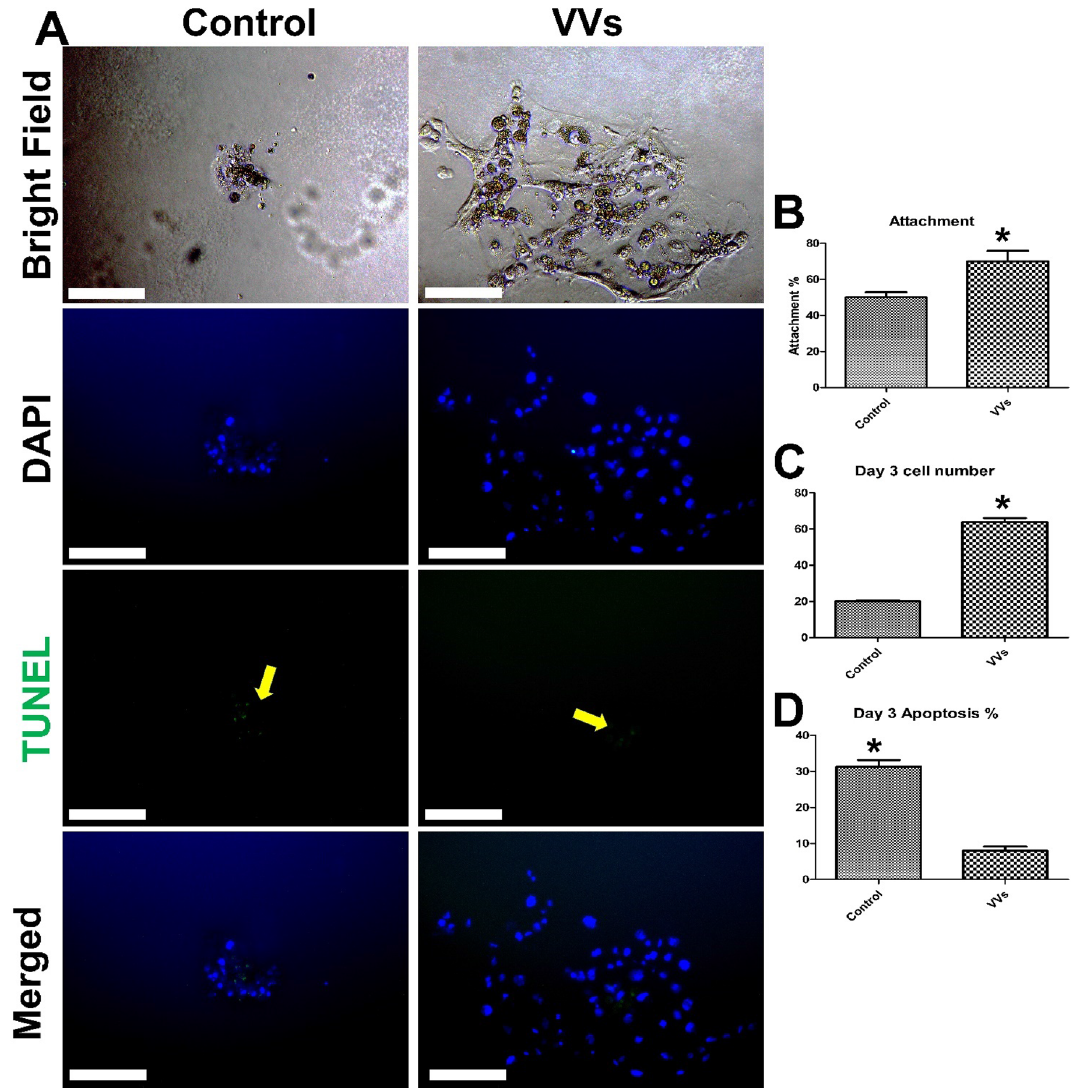
Figure 6. Effects of VVs on porcine embryo attachment and development. ( A ) Day-7 zona-free embryos (n = 20, 3 replicates) were cultured on Matrigel-coated dishes in micro drops of culture medium in a humidified atmosphere of 5% CO 2 for 72 h. The control group was cultured in a plain culture medium and the VVs groups was supplemented with VVs of 2.6 × 10 6 particles/mL. All groups were imaged in a bright field before staining with TUNEL assay and contrasted with 4 ′ ,6-diamidino-2-phenylindole stain. Scale bar = 100 µm. ( B , C , and D ) Graphs show the attachment percentage, the cell number in the groups, and the apoptosis percentages, respectively. Values (mean ± SD) were compared using Student’s t-test. Values denoted by an asterisk (*) were considered statistically different ( p <